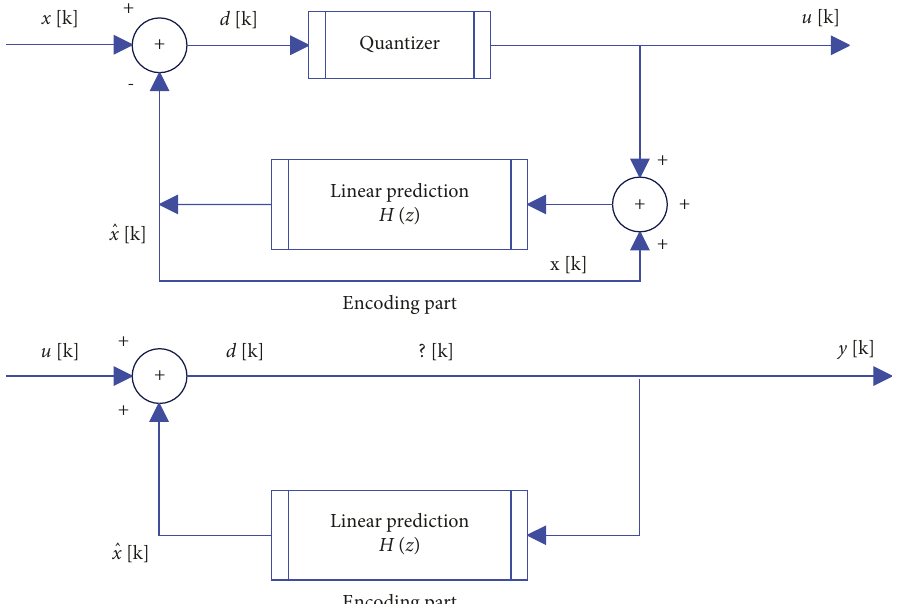
Figure 3: Model structure at both ends of the